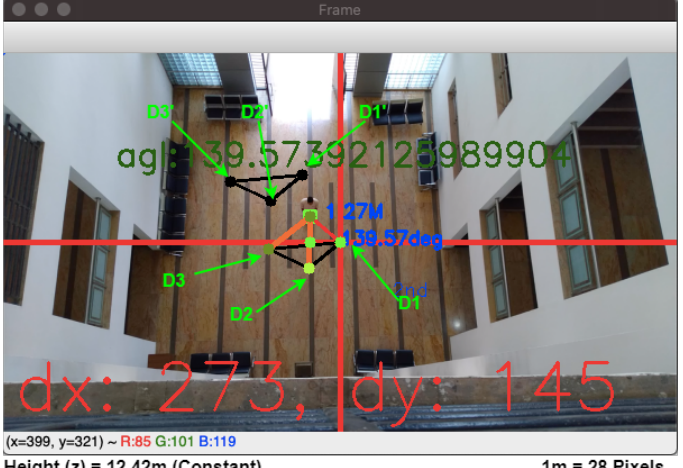
Figure 11. Individual drone positions in master drone image calculated using Equation (4); initial triangle arrangement visualized as individual drones D1, D2, and D3. D1 (cid:48) , D2 (cid:48) , and D3 (cid:48) triangular formation is the new estimated position as the master drone changes its position from D1 to D1 (cid:48)